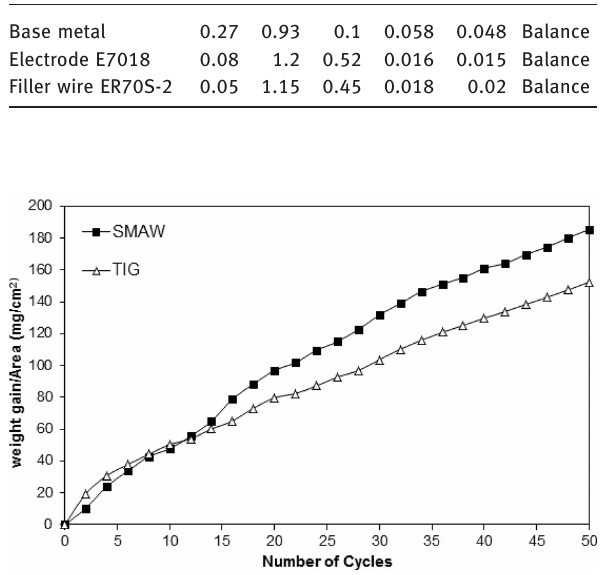
Figure 1: Weight gain plot for welded steels exposed to air at 900°C.